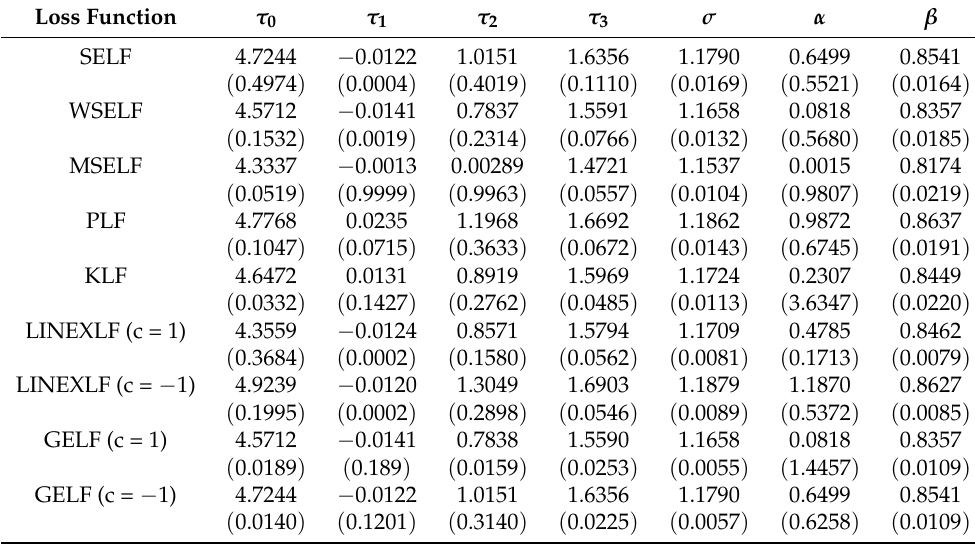
Table 5. A summary of the Bayesian analysis of the LATOLLW regression based on heart trans- plant data.